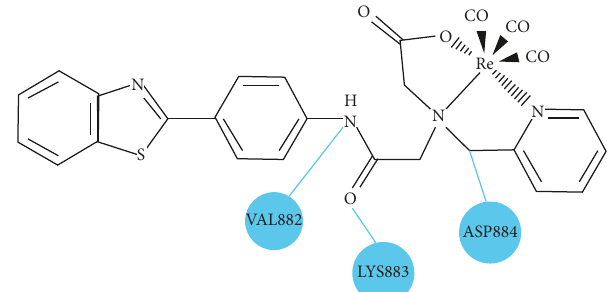
Figure 5: H-bonds performed in molecular docking simulation with the ReABT-PI3K